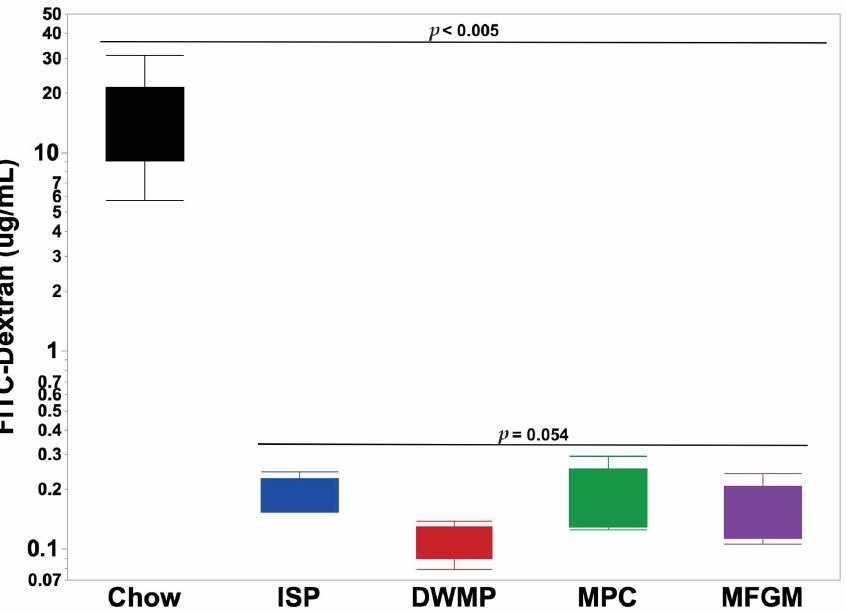
Figure 5. FITC-dextran permeability of chow-fed vs. purified diet-fed mice. Chow-fed mice ( n = 10) averaged 18.9 ± 5.77 ug/mL FITC-d plasma fluorescence, a 118-fold increase over the average of all purified diet-fed mice. Purified diets ( n = 60) averaged 0.16 ± 0.01 ug/mL FITC-d plasma fluorescence.